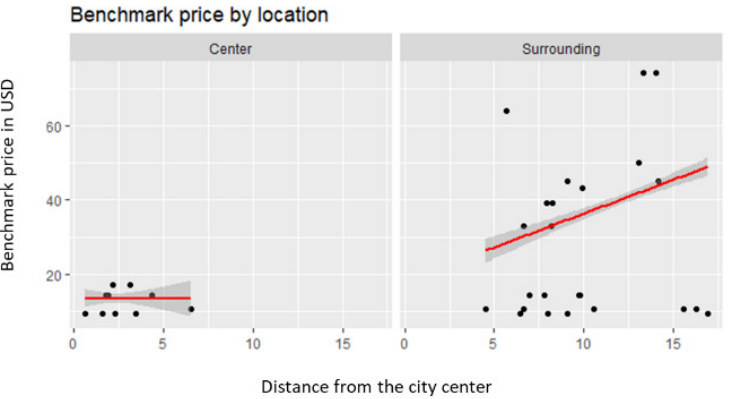
Figure 15. Benchmark urban land prices per m 2 in USD trends against distance from the center in kilometers.